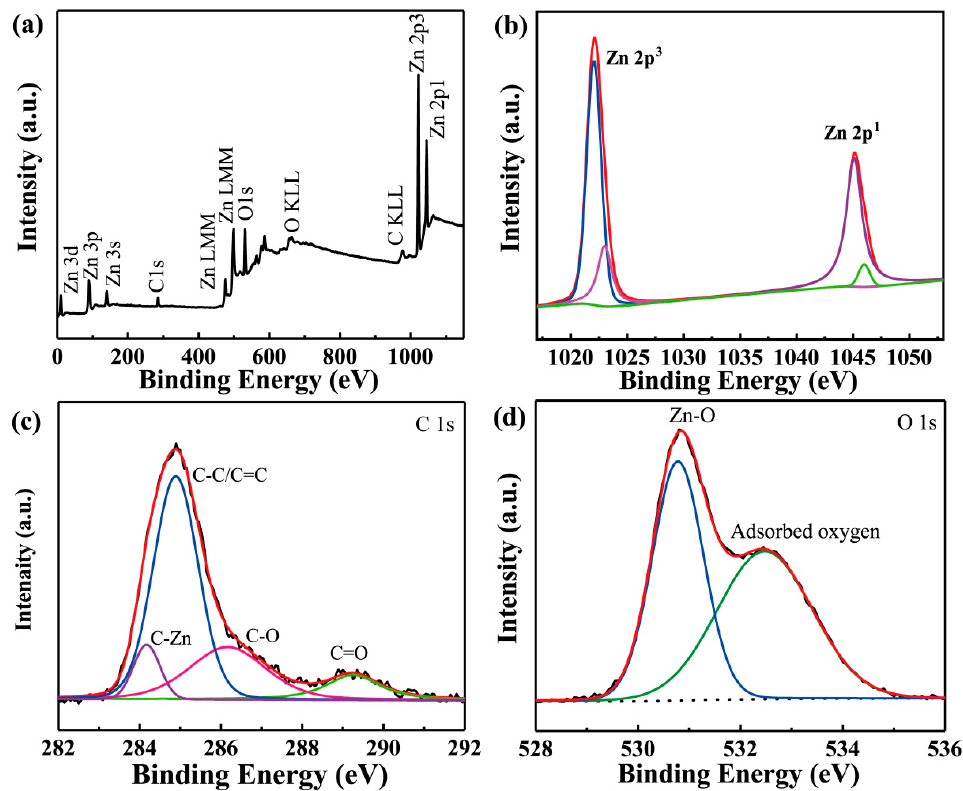
Figure 3. ( a ) XPS survey spectrum of the ZnO/GO NSs-525; high-resolution core-level XPS spectra: ( b ) Zn 2p, (c) C 1s and ( d ) O 1s.